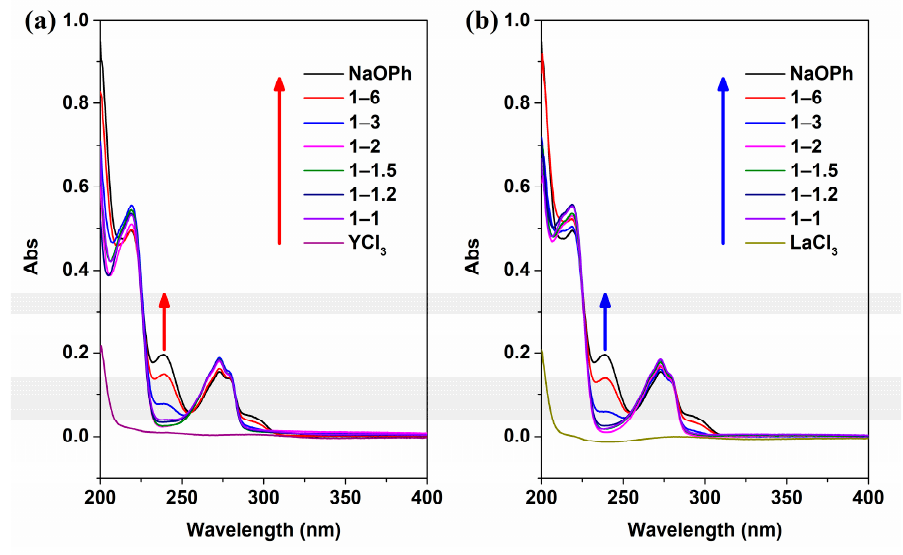
Figure 4. UV-vis characterizations of the reactions of ( a ) YCl 3 -nNaOPh and ( b ) LaCl 3 -nNaOPh (n = 1–6) with the increase in molar ratio of NaOPh.